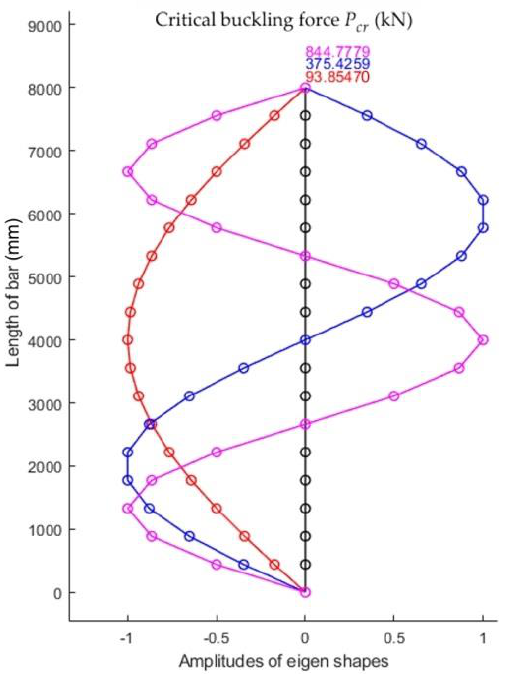
Figure 3. The first three shapes of stability loss and corresponding critical buckling forces for the bar, whose geometrical and material characteristics are given in Table 1.